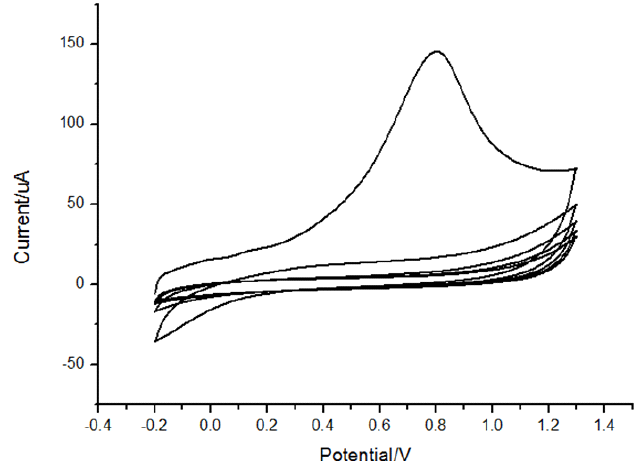
Figure 3. CV of over oxidation of polypyrrole film and quercetin elution on MIP/GO/GC in 0.1 mol/L PBS (pH = 7.0). Scan rate: 0.1